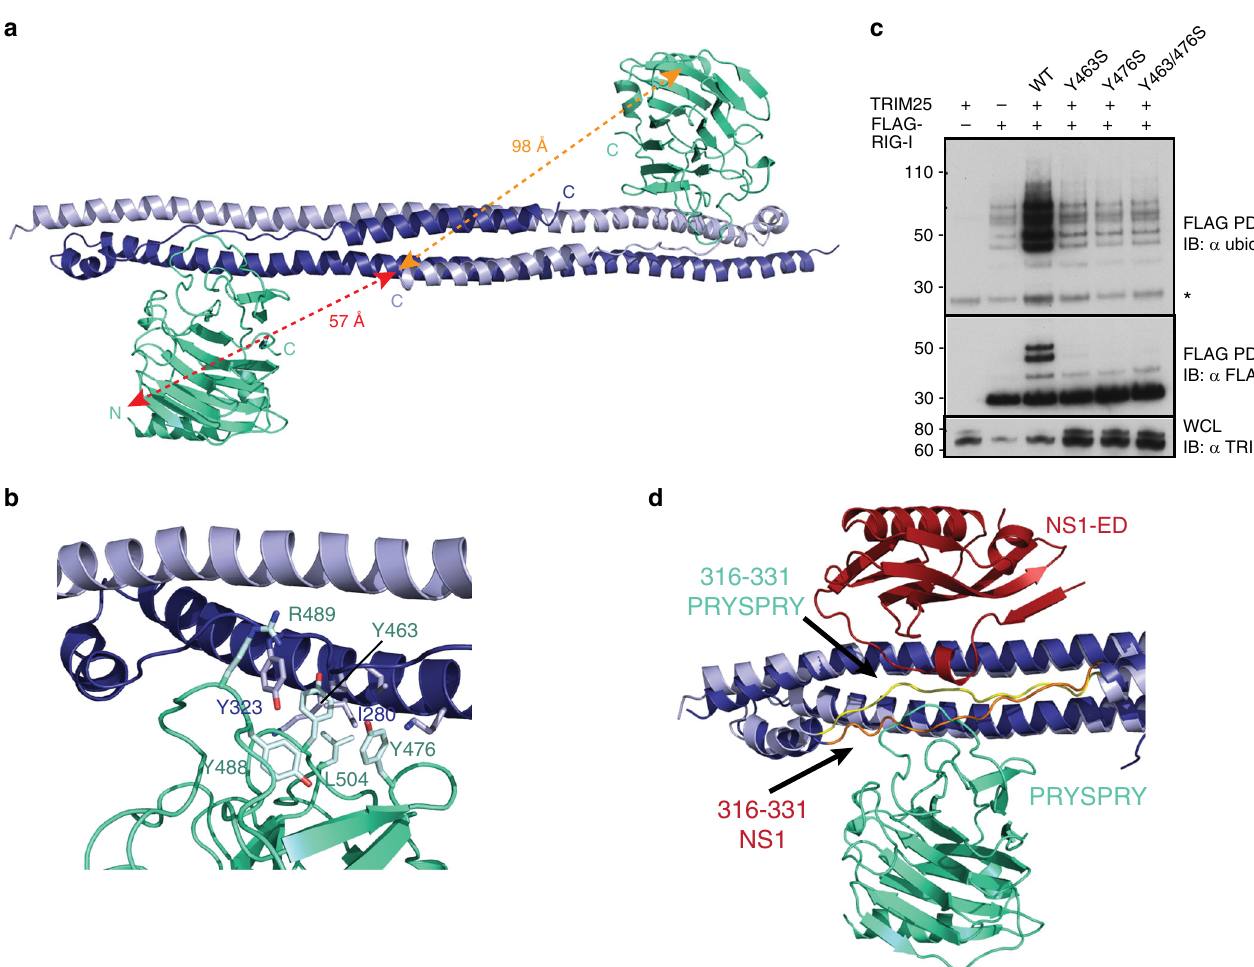
Fig. 4 Crystal structure of TRIM25 CC-PRYSPRY. a The TRIM25 CC dimer (in dark and light blue) with two PRYSPRY domains bound at either end in green cyan. There is no electron density for the linker connecting the CC and PRYSPRY domains. The distance between the N-termini of the PRYSPRY domains and C-terminus of one CC chain is indicated. b Close-up view of the interface between the CC and PRYSPRY domain. Residues described in the text are shown as ball and stick. c Ubiquitination assays of the tandem CARDs of RIG-I with TRIM25 to test the importance of Y463 and Y476 in stabilising the observed CC-PRYSPRY arrangement and promoting substrate ubiquitination. FLAG-RIG-I-2CARD and TRIM25 were co-transfected into HEK293T cells and WCLs were subjected to IP with anti-FLAG beads and immunoblotted with α -ubiquitin and α -FLAG antibodies. The asterisk indicates an unspeci fi c band. d Comparison of the positions of the PRYSPRY domain (green cyan) and the NS1 ED (red), highlighting the changes in the position of the linker connecting the CC and PRYSPRY domain, induced by binding to